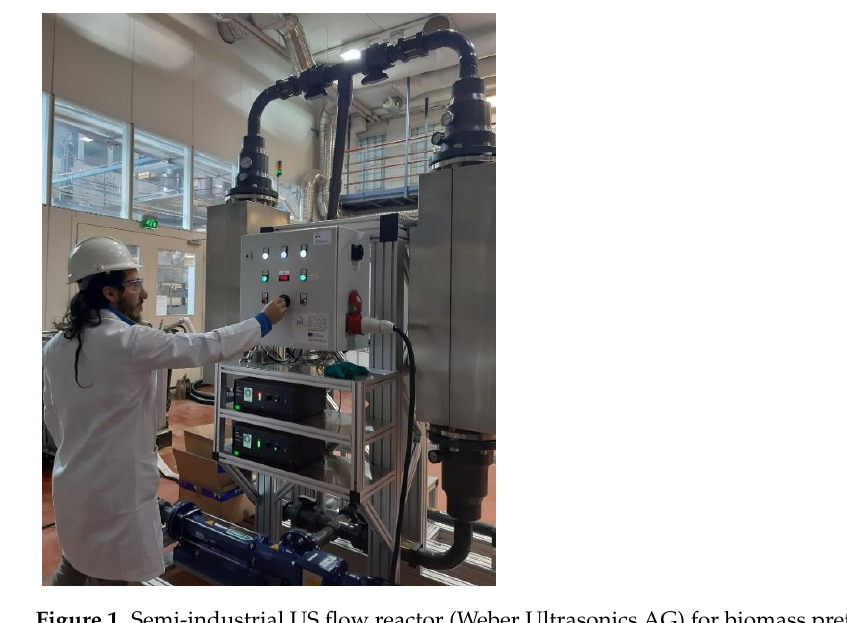
Figure 1. Semi-industrial US flow reactor (Weber Ultrasonics AG) for biomass pretreatment.